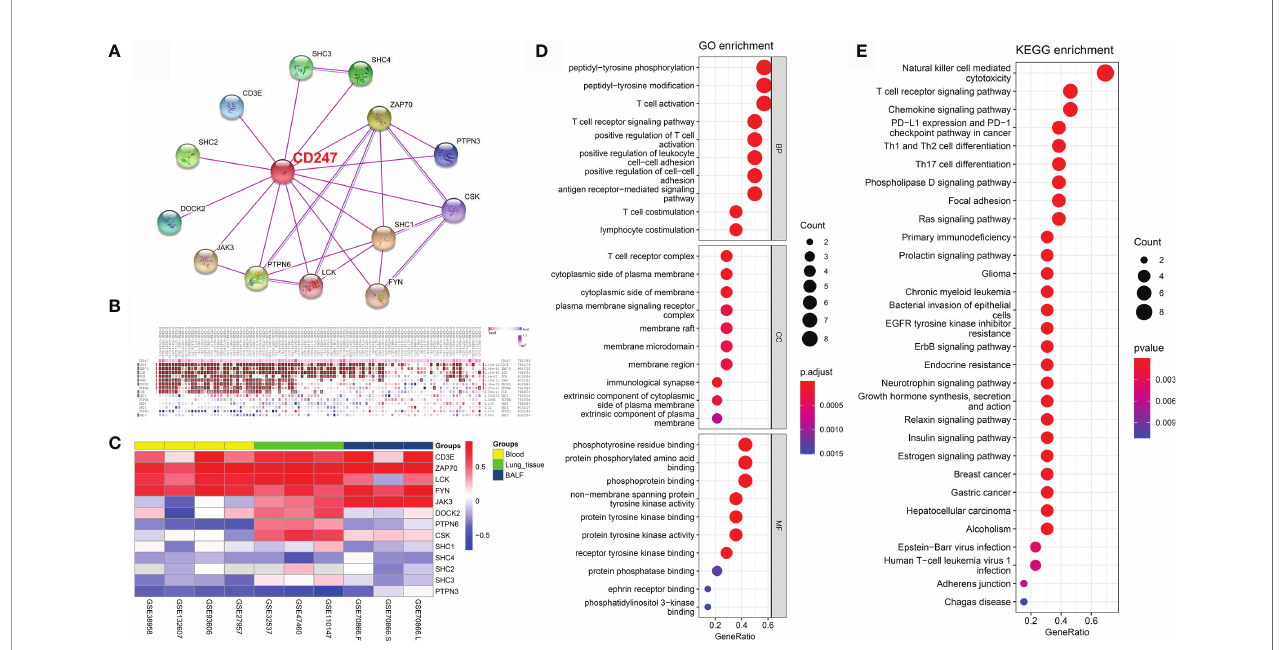
FIGURE 6 | CD247-related gene enrichment analysis. (A) The available experimentally determined CD247-binding proteins using the STRING tool. (B) According to the MEM database, the co-expression correlations between CD247 and 13 selected genes were analyzed. (C) The corresponding Pearson coef fi cients of the 13 genes correlated with CD247 were visualized by the heatmap in the blood, lung tissue, and BALF samples. The darker shade of red or blue represents the higher correlation level. (D) The top 10 signi fi cant terms in the biological processes (BP), cellular component (CC), and molecular function (MF) analysis for the 14 genes. (E) The top 30 signi fi cant terms in the KEGG pathways analysis for the 14